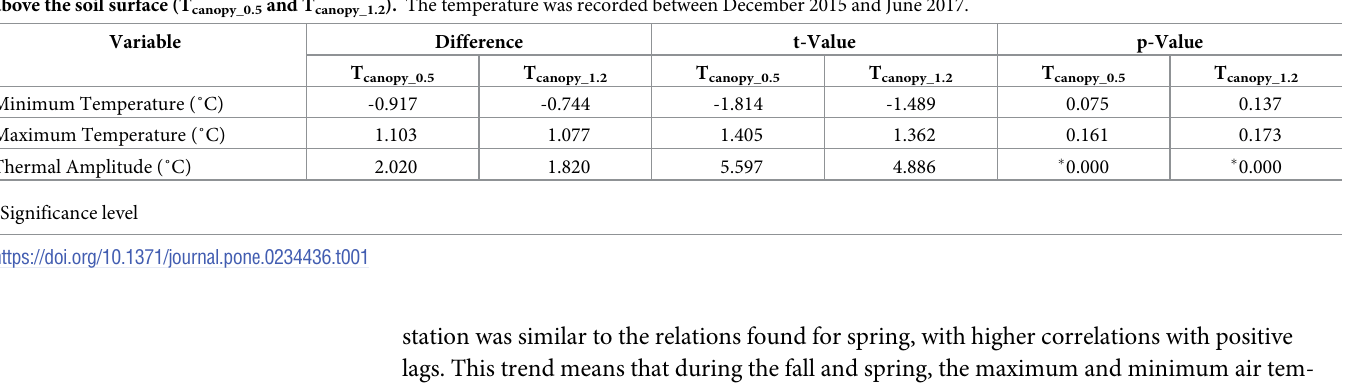
station was similar to the relations found for spring, with higher correlations with positive lags. This trend means that during the fall and spring, the maximum and minimum air tem- perature inside the canopy occurred after the maximum and minimum air temperature were observed at the weather station (Fig 6b and 6c). In fact, during spring the maximum and mini- mum air temperature were recorded between 30 and 45 minutes after the extreme values were recorded at the weather station (Fig 6c).